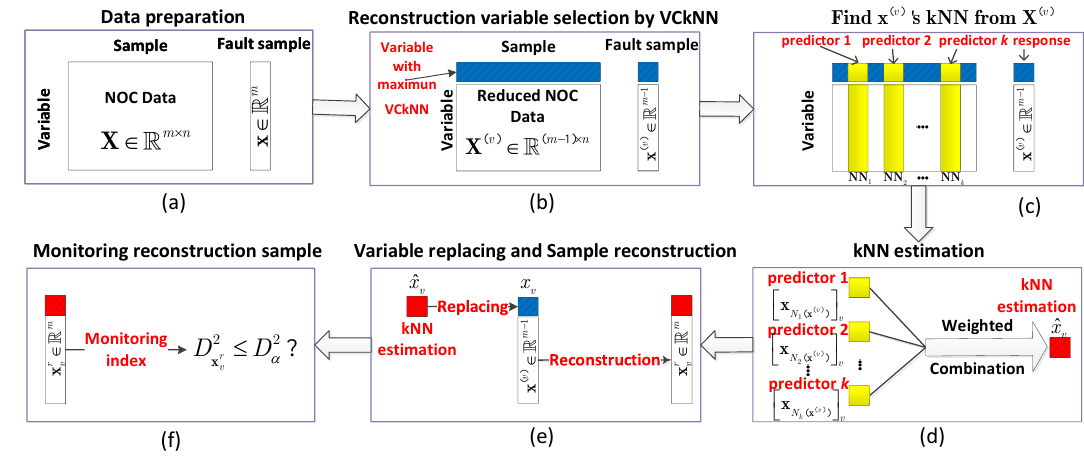
Figure 1. The flowchart of fault sample reconstruction by k-nearest neighbor (kNN)